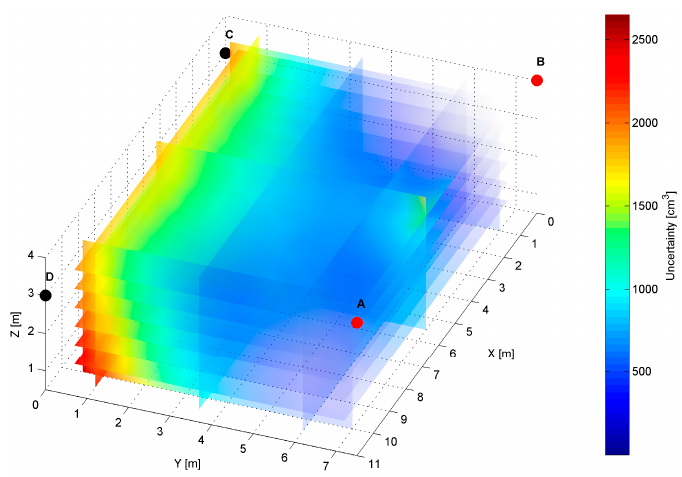
Figure 11. Volumetric slice plot of uncertainty-precision distribution for location sensors A and B .